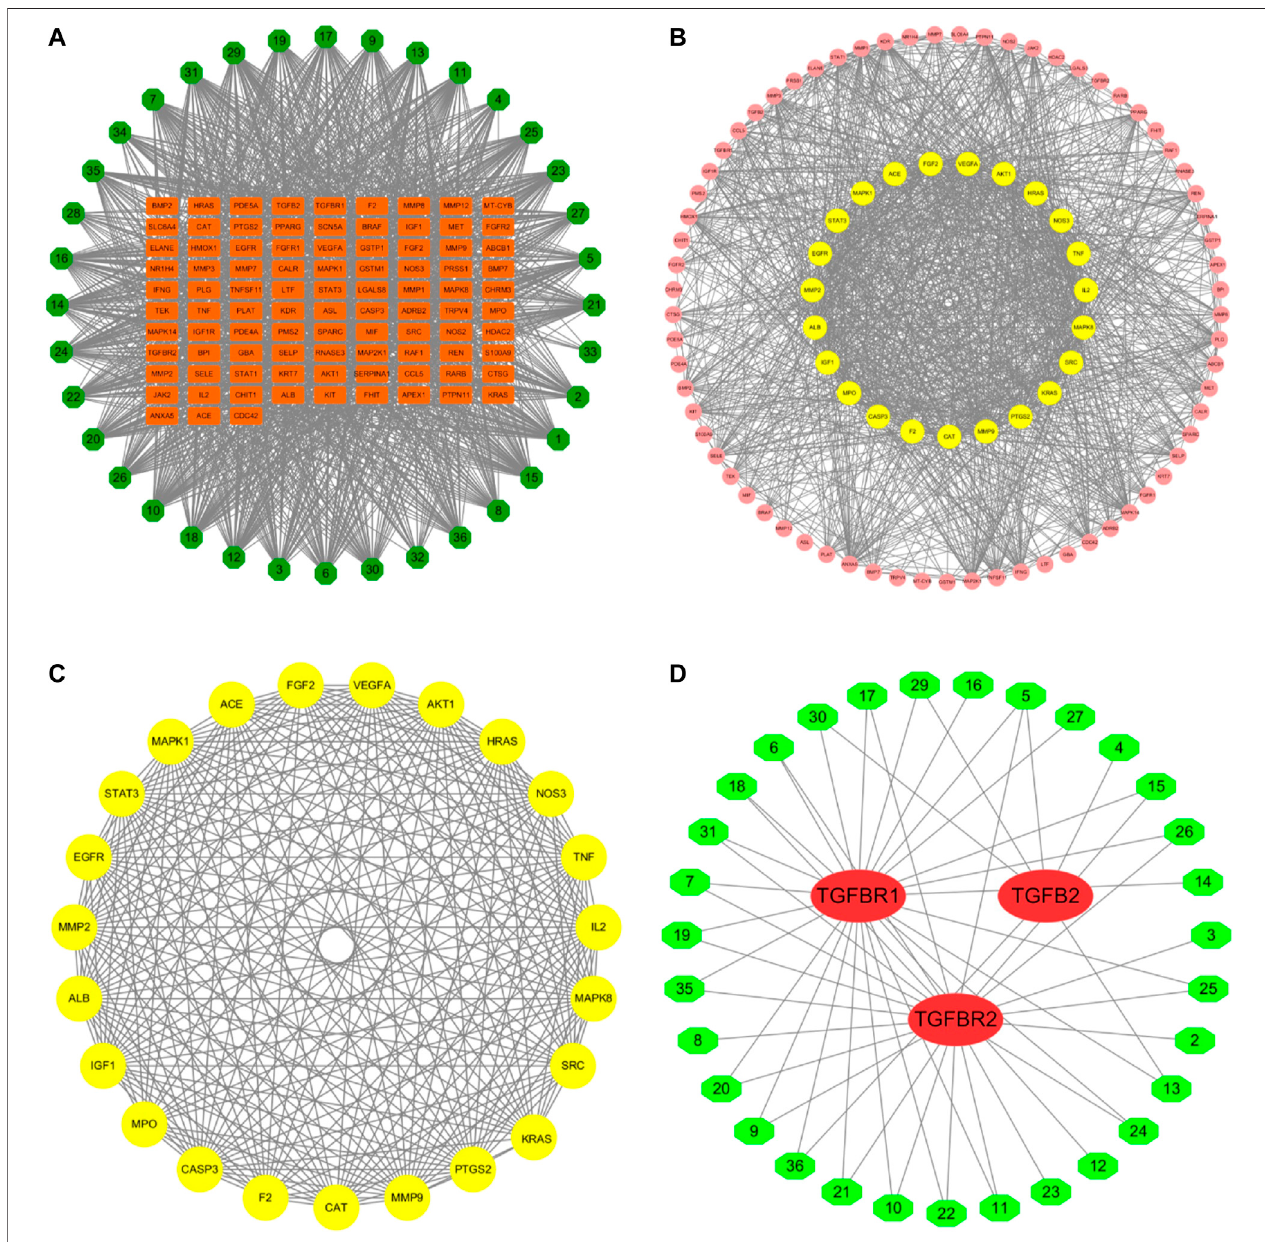
FIGURE 2 | Potential targets of WBT formula were predicted by network pharmacology. (A) The network of the 36 selected components of WBT formula and potential targets was constructed. The green octagons represent the components ID of 36 compounds, and the orange rectangles represent the potential targets participated in PF. (B and C) PPI networks of 93 potential targets and 23 core targets are shown after screening with the degree ≥ 27, betweenness ≥ 0.08, and closeness ≥ 0.58.Thecirclerepresentstheall-potential targets, andtheyellow circlerepresents thecoretargets (D) .Thenetworkof31activecomponentsand the targetsin TGF- β pathway wasanalyzed.The redovalsrepresenttheTGF- β – related targets, andthe greenhexagons represent the31screenedcomponents fromWBT formula.